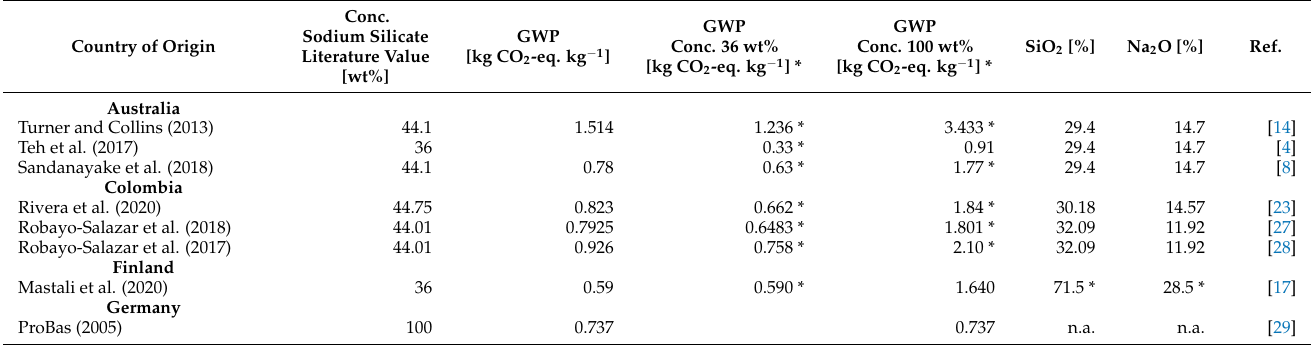
Table 1. GWP Data of Sodium Silicate—Literature Values and Calculated Values (*) for Comparison of Different Weight Concentrations (36% and 100%) Sorted by Country of